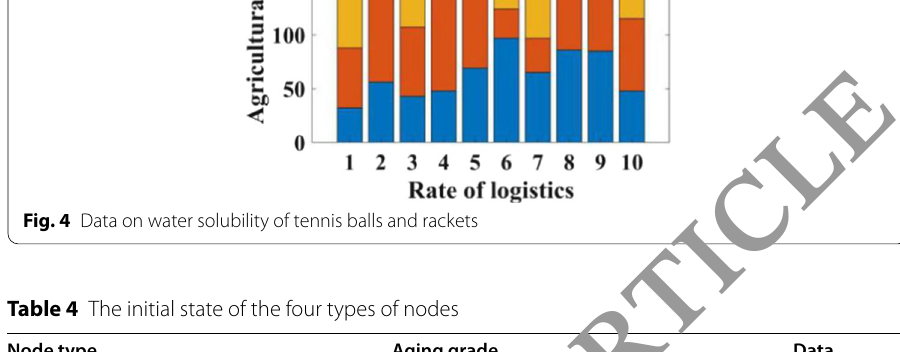
Table 4 The initial state of the four types of nodes Node type Aging grade Data sending rate (kb/s) A 5 60 B 4 90 4 110